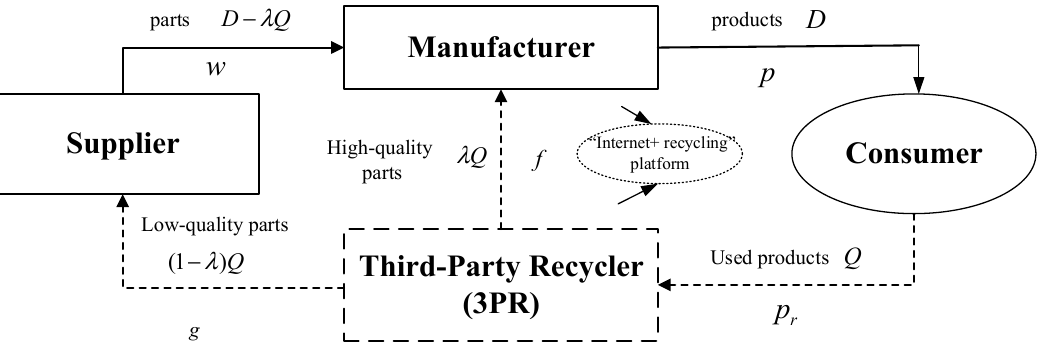
Figure 1. A two-echelon remanufacturing CLSC with an “Internet+ recycling” platform. Table 2. All parameters and variables used in this research.